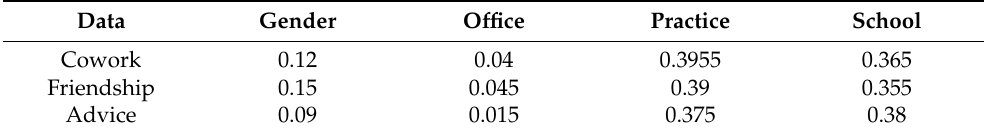
Table 1. M -value of different labels on the Lazega Lawyers network. Data Gender Office Practice School Cowork 0.12 0.365 Friendship